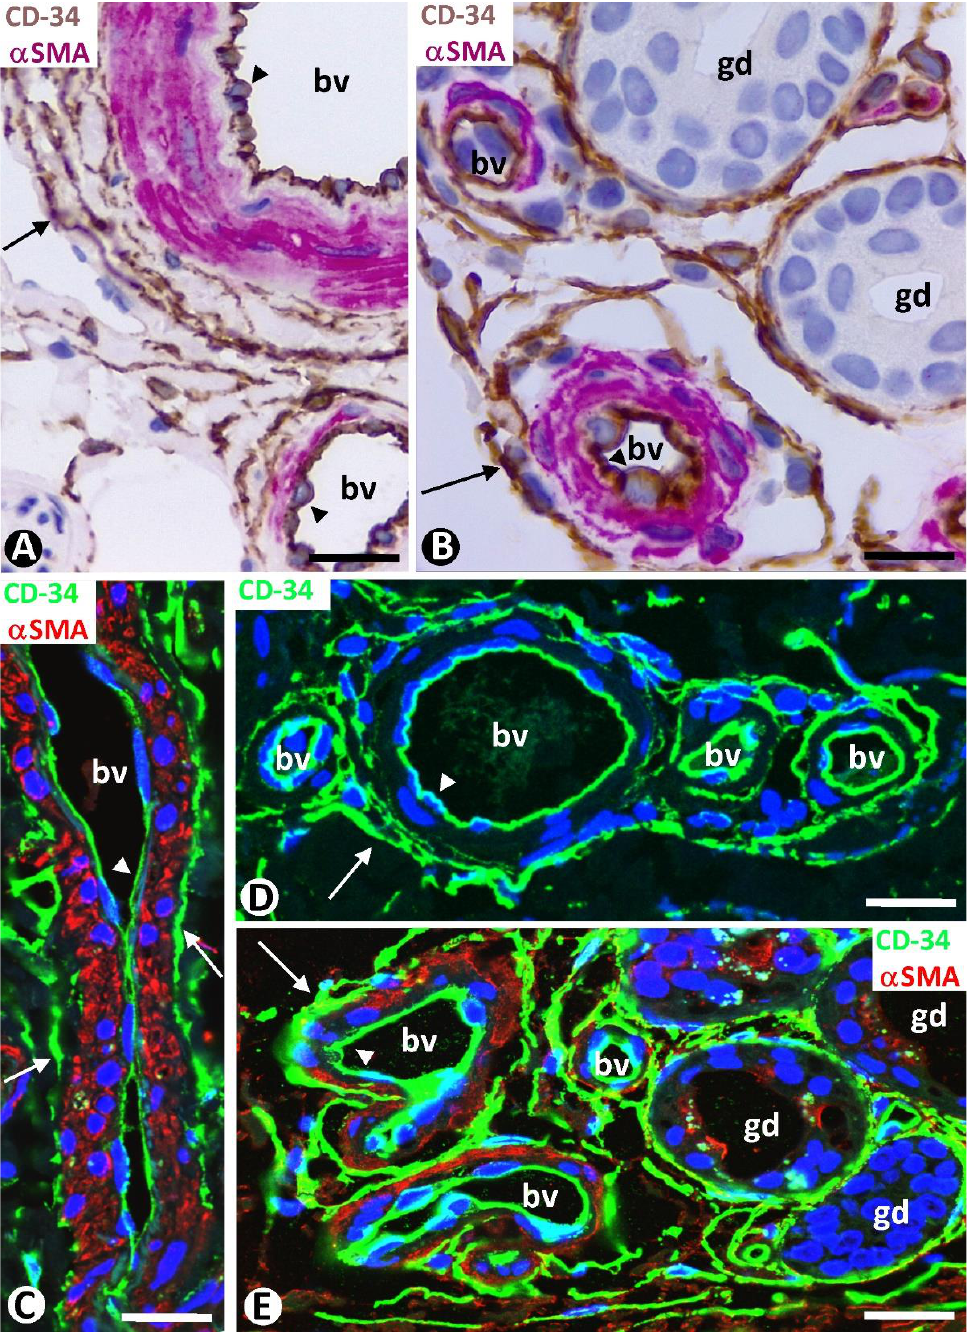
Figure 3. Pre-existing blood vessels (bv in ( A , C , D )) and complex structures with vessels and glands (bv and gd, respectively, in ( B , E )) in areas without perivascular newly formed vessels or inflam- matory infiltrate. Three layers in the pre-existing blood vessels are observed in ( A , B ), with double immunochemistry for CD34 and αSMA. Intima layer, formed by CD34+ ECs (arrowhead) (brown); media layer, made up of αSMA+ pericytes or vascular smooth muscle cells (red); and external layer with CD34+SCs/TCs (arrows) (brown). Similar images in immunofluorescence in ( C , E ): Intima layer (arrowhead) (green), media layer (red), and external layer with CD34+SCs/TCs (arrows) (green). In ( D ), CD34 expression is highlighted in both ECs (arrowhead) and CD34+SCs (arrows) by immuno- fluorescence, with only CD34 (green). Note the formation of a labyrinthine system by CD34+SCs/TCs around complex structures (blood vessels and glands) in ( B , E ). Counterstain is with hematoxylin in ( A , B ) and with DAPI in ( C – E ). Bar: ( A , B ): 20 µm; ( C , D ): 35 µm; ( E ): 25 µm.